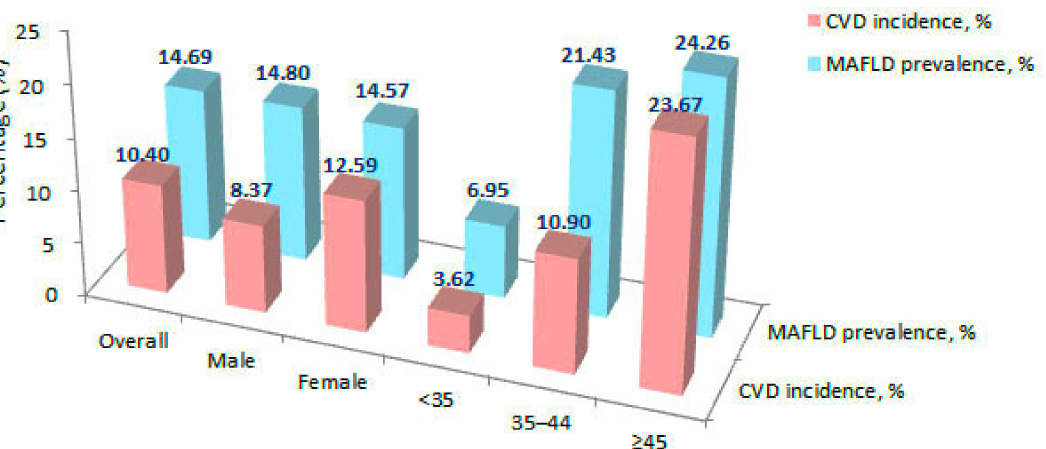
Figure 1. The prevalence of metabolic dysfunction-associated fatty liver disease and the incidence of cardiovascular disease according to sex and age in the overall study population (MAFLD, metabolic dysfunction-associated fatty liver; CVD, cardiovascular disease).